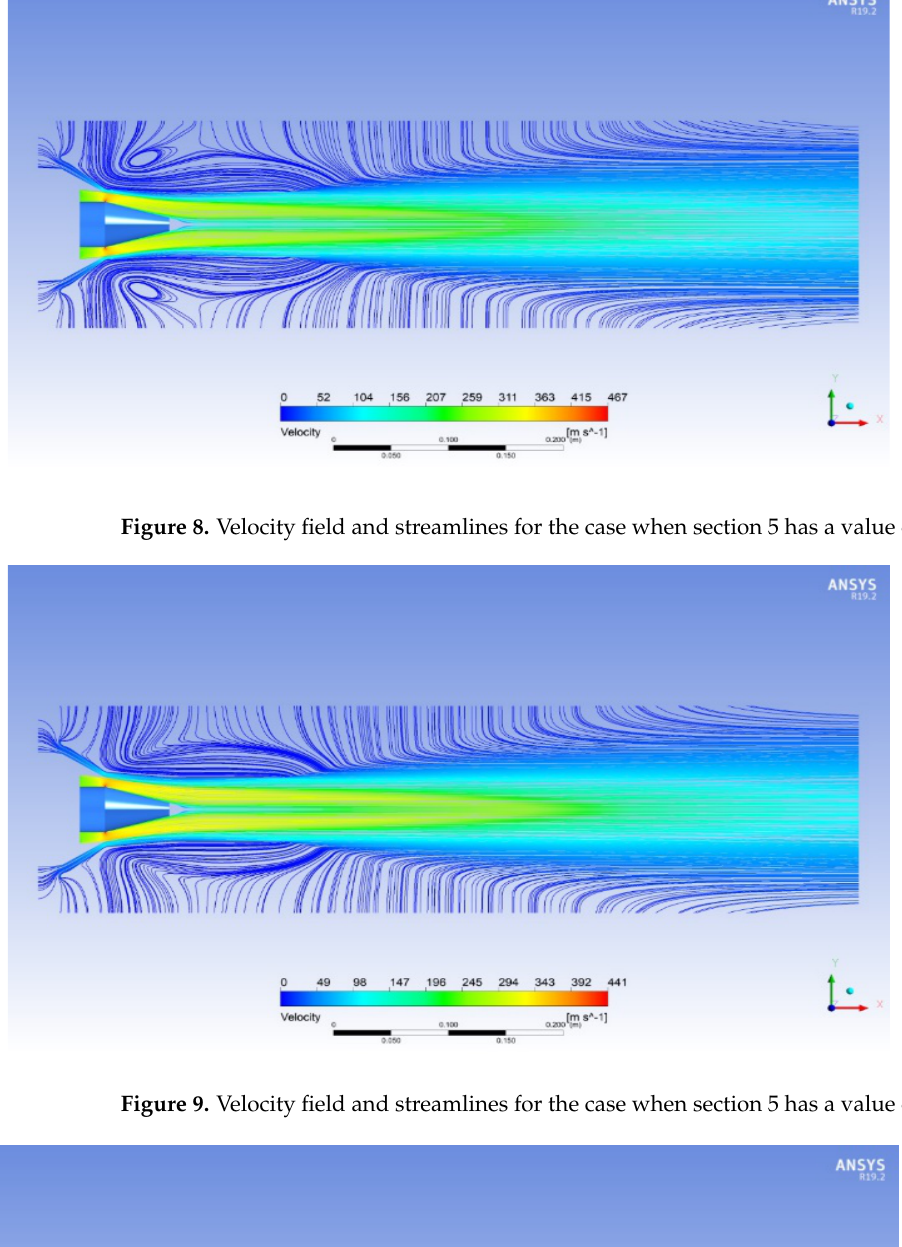
Figure 7. Velocity field and streamlines for the case when section 5 has a value of 1 mm.